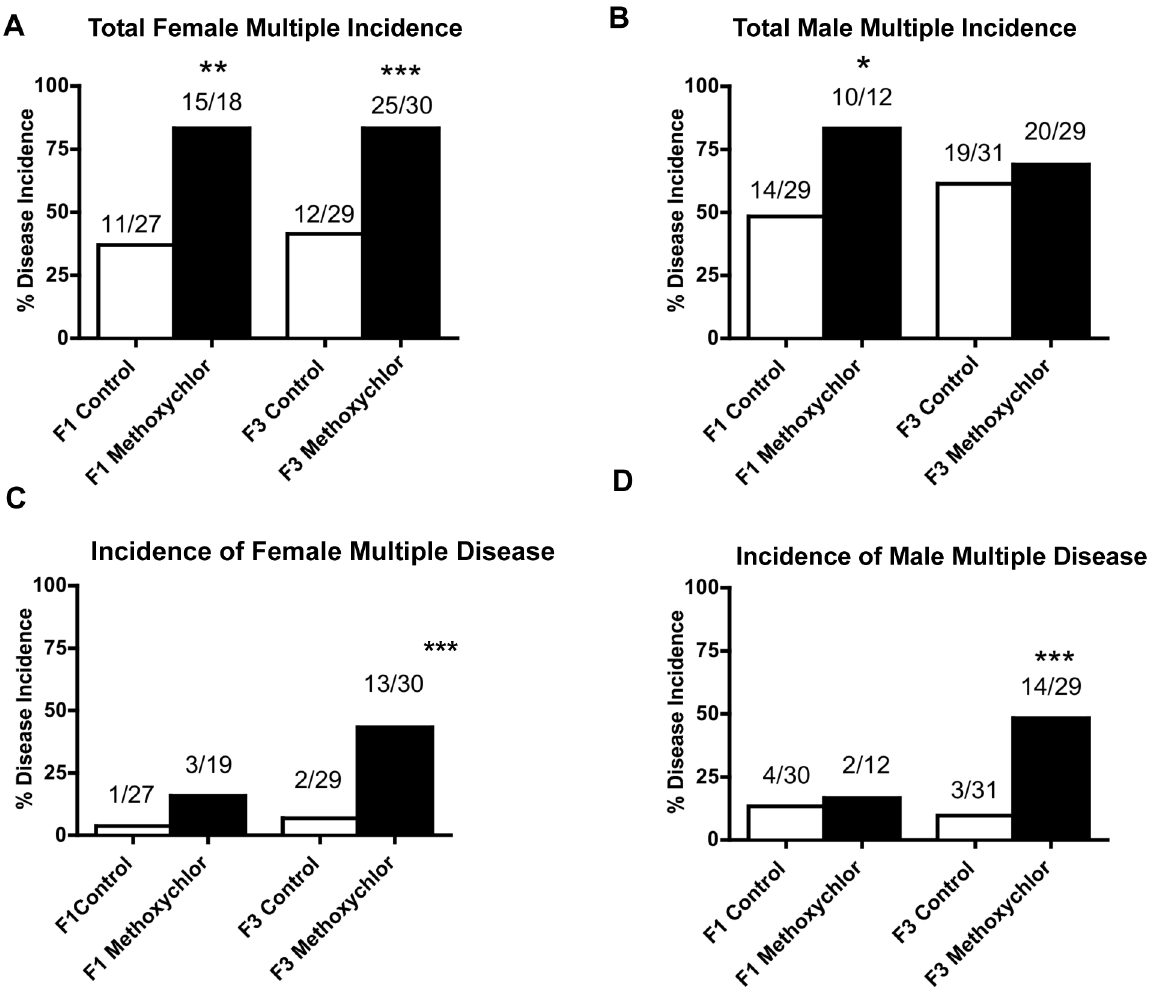
Figure 4. Ancestral exposure to methoxychlor and adult-onset transgenerational disease in rats. Incidences of F1 and F3 generation total female disease (panel A), total male disease (panel B), female multiple disease (panel C) and male multiple disease (panel D) in control and methoxychlor lineages. The number of diseased rats / total number of rats is shown above the respective bar graphs (* P , 0.05; ** P , 0.01; *** P , 0.001).